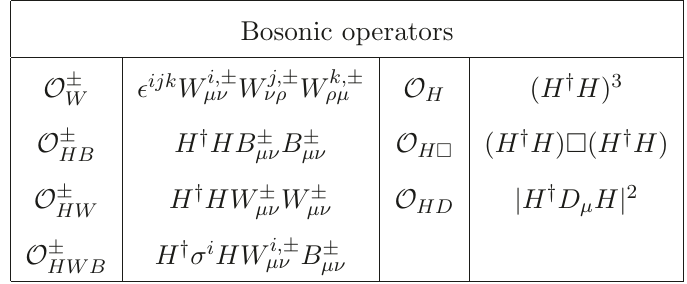
Table 2 . Bosonic operators in the Warsaw basis. We define the holomorphic and anti-holomorphic operators/Wilson coefficients as on the right side do not have defined holomorphic